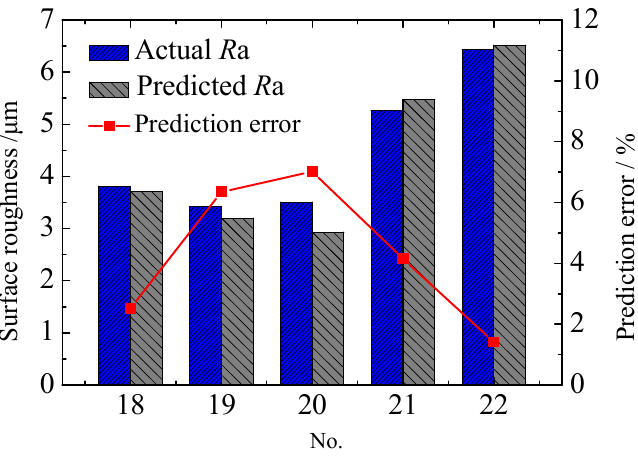
Figure 4. Training results of the ANN.